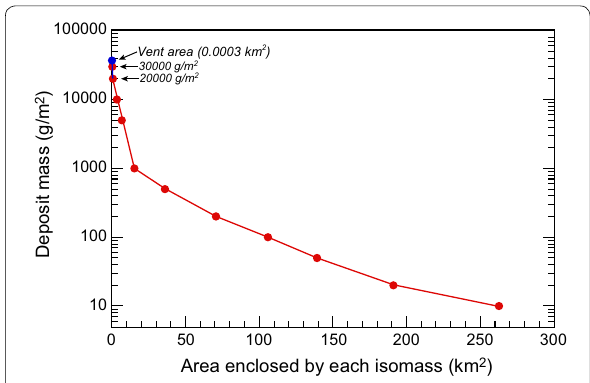
Fig. 4 Relation between area (km 2 ) and mass (g/m 2 ) of